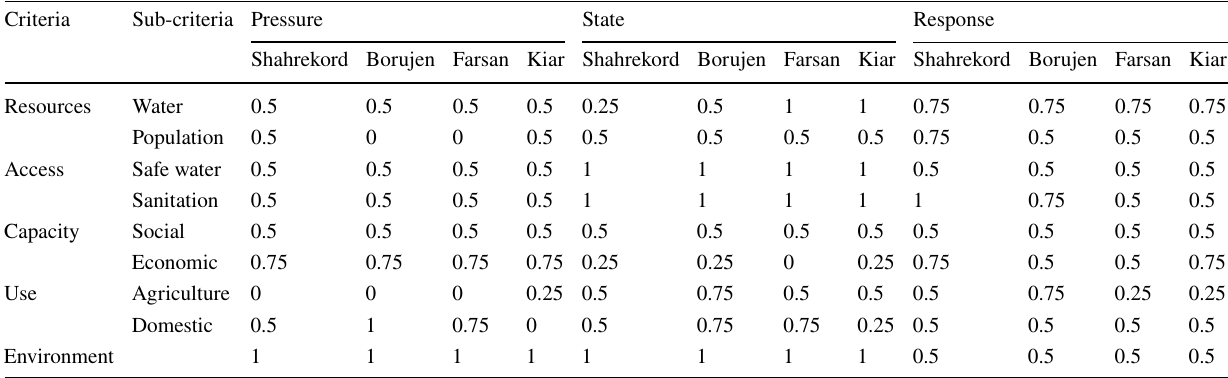
Table 4 eWPI parameters' scores for districts of Beheshtabad Watershed Criteria